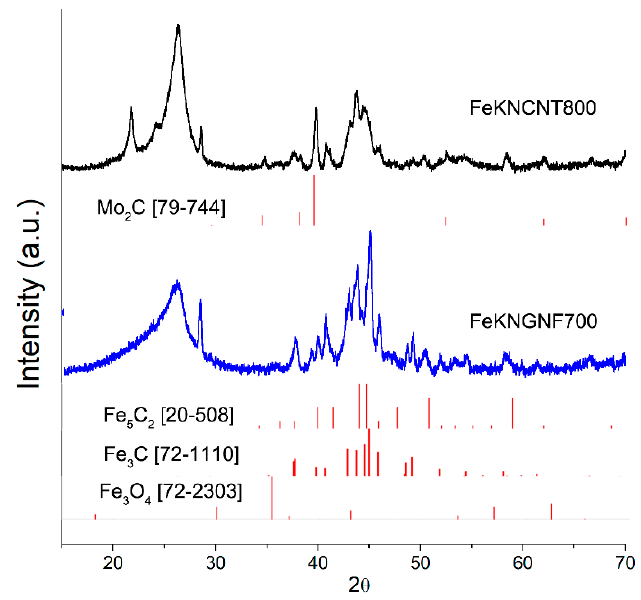
Figure 6. XRD pattern of spent FeKNGNF700 catalyst.